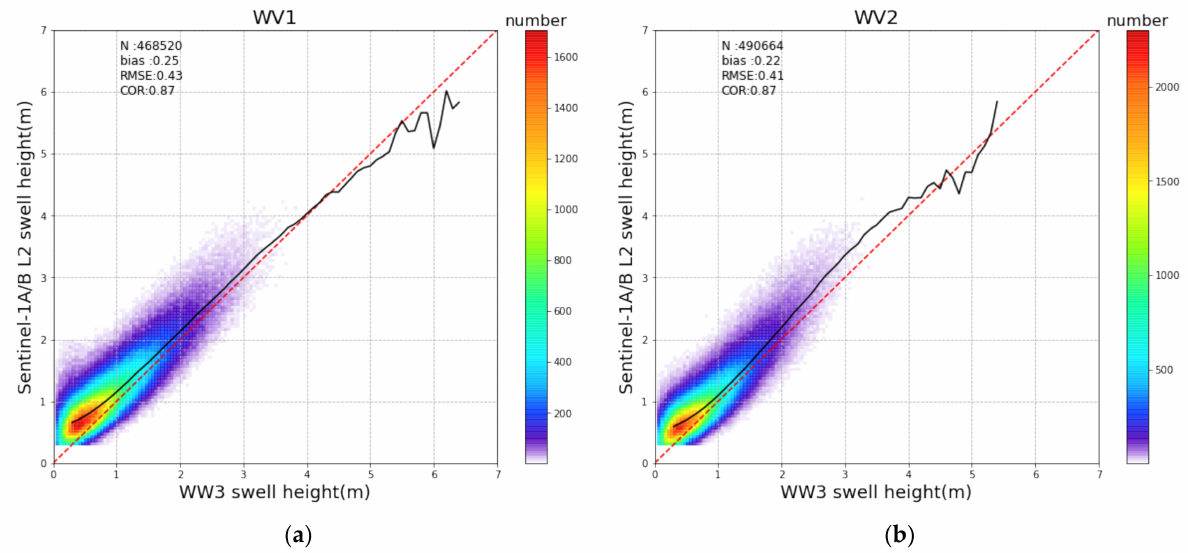
Figure 11. Intercomparisons of the partitioned swell heights for S-1A/B versus WW3 hindcasts, from match-ups of S1L2WW3-1, as defined in Table 1. ( a ) The results with the S-1A/B data in WV1 (incidence angle of 23.5 ◦ ) and ( b ) WV2 (incidence angle of 36.5 ◦